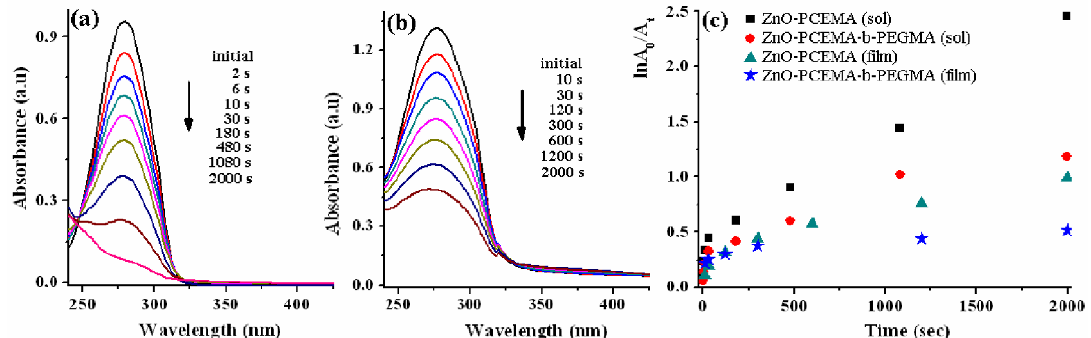
Figure 9. The changes in the UV spectra of the ZnO-PCEMA-Br-2 macroinitiator in THF solution (a) in thin film (b), and the kinetic evaluation of ZnO-PCEMA-Br-2 and ZnO-PCEMA- b -PEGMA-Br-2 in solution and in film (c).